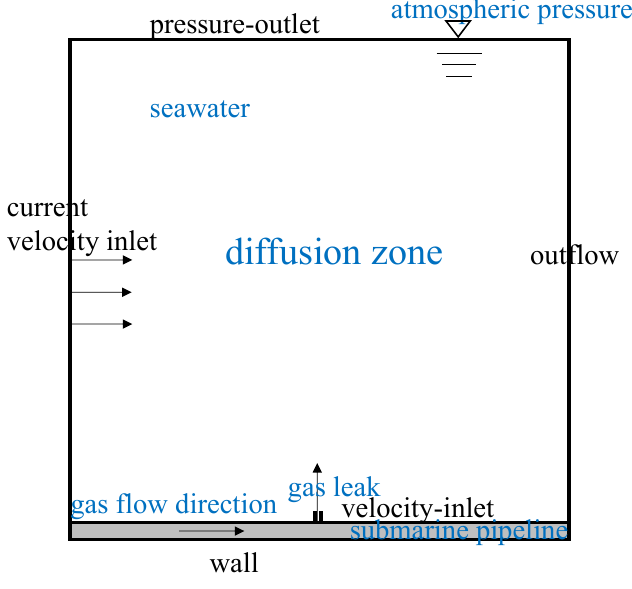
Figure 1. Calculation area and boundary conditions.